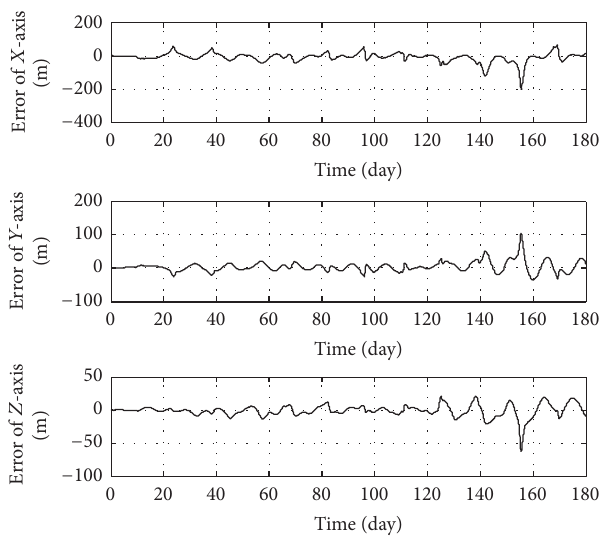
Figure 9: The AOD position error of 𝐿 1 using IKFF.